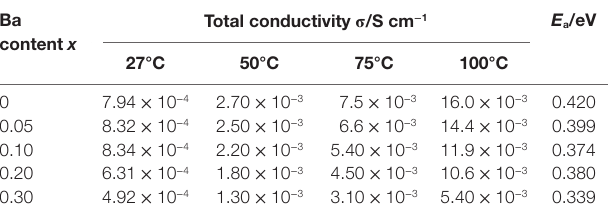
TaBle 2 | Total conductivity σ at different measurement temperature and activation energy E a for llBZT with different Ba contents x = 0–0.30. Ba content x